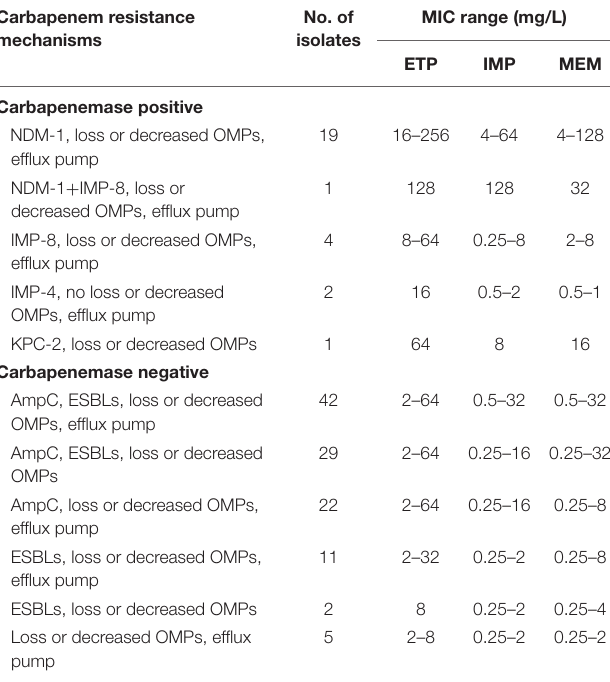
TABLE 2 | Distribution and corresponding carbapenem MIC ranges for strains with different resistance